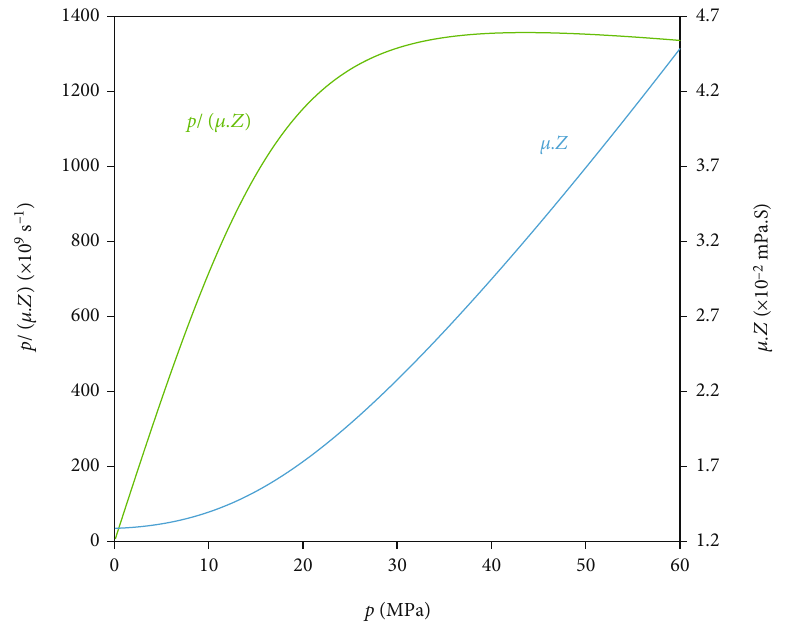
) and gas viscosity ( μ ) vs. pressure ( p ) for case g